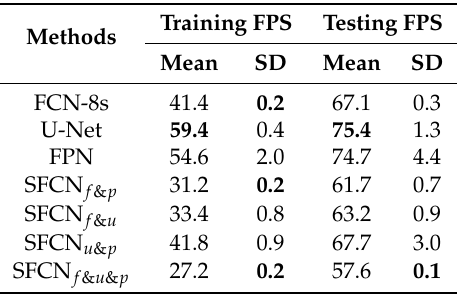
Table 5. Comparison of the computational efficiencies of FCN-8s, U-Net, FPN and four ensemble fully conventional networks. For each column, the highest mean values and lowest SD are highlighted in bold